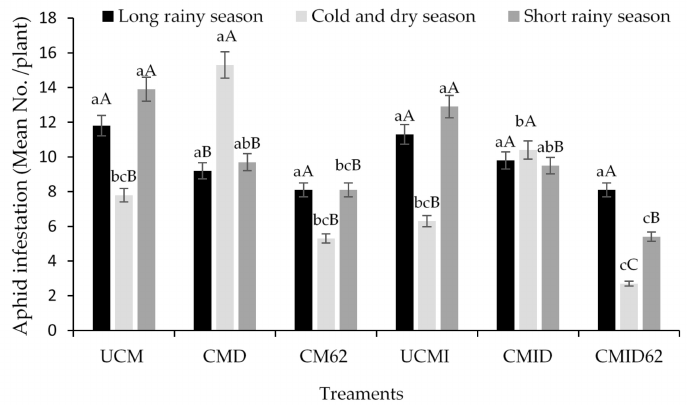
Figure 1. Mean aphid population density (number of aphids per plant) after treatment for the three seasons. UCM (untreated cowpea monocrop), UCMI (untreated cowpea–maize intercrop), CM62 (cowpea monocrop treated with Metarhizium anisopliae ICIPE 62), CMI62 (cowpea–maize intercrop treated with M. anisopliae ICIPE 62), CMD (cowpea monocrop treated with Duduthrin), and CMID (cowpea–maize intercrop treated with Duduthrin). Data presented are mean ± SE at P < 0.05. Means followed by the same lowercase letters and uppercase letters are not significantly di ff erent within a season and across / among seasons,